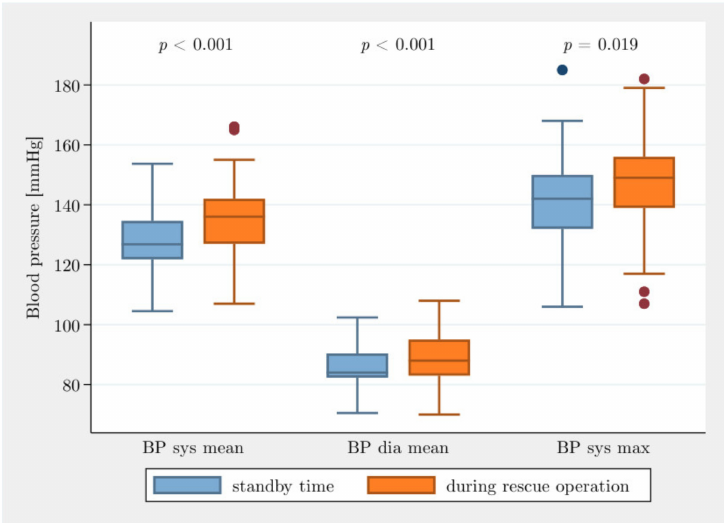
Figure 1. Blood pressure (BP sys mean, BP dia mean, BP sys max) during standby time and rescue op-